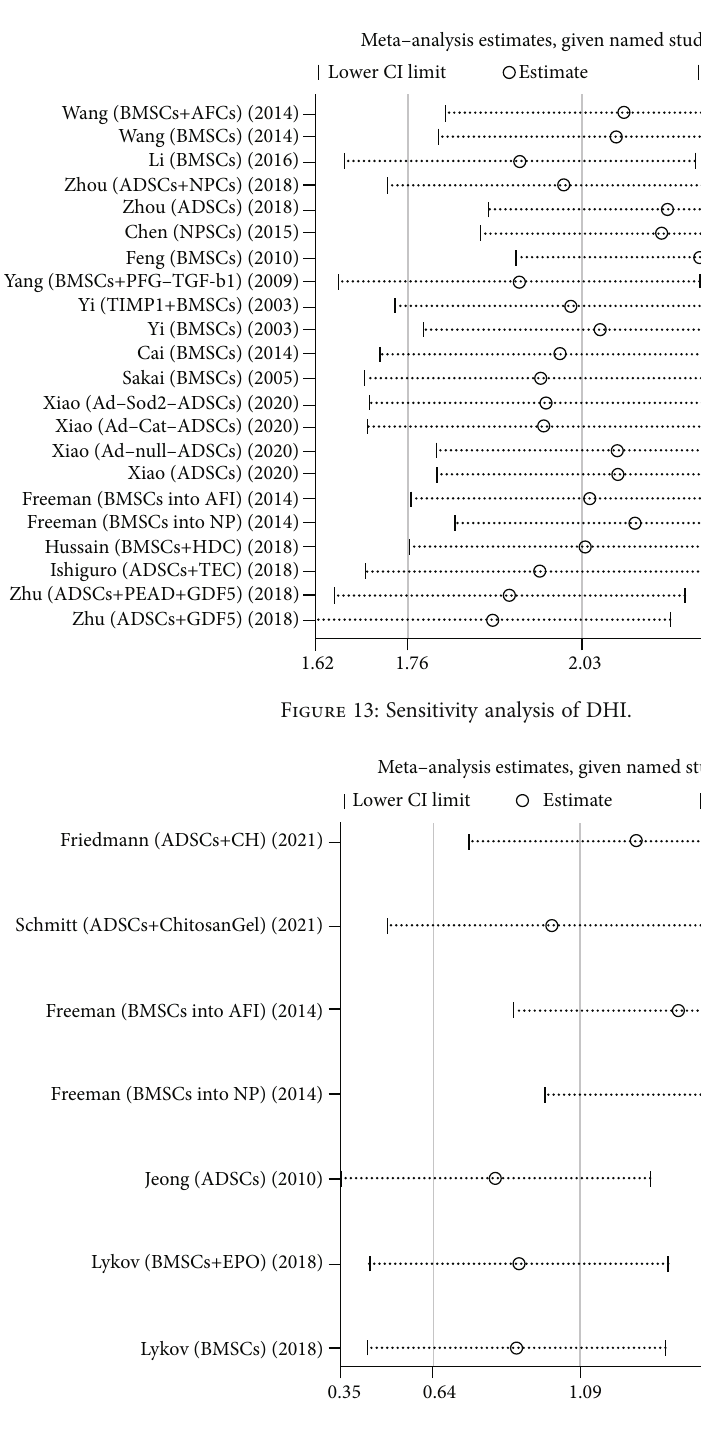
Figure 14: Sensitivity analysis of disc